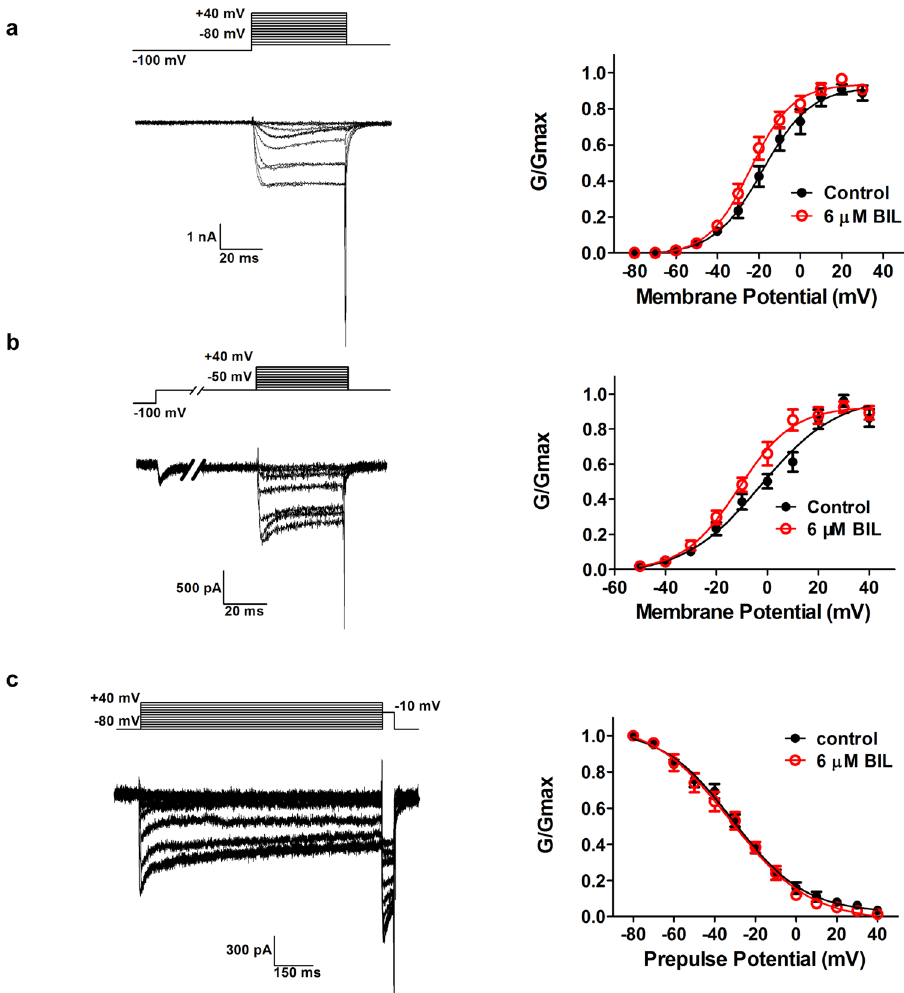
Figure 3. Effects of Bilirubin on activation and steady-state inactivation of VGCCs in bushy neurons. ( a ) Representative traces recorded from a bushy neuron obtained by a 50 ms prepulse at − 100 mV to various potentials followed by a 40 ms test pulse to + 40 mV (10 mV increments) are shown (left). Activation of VGCCs in control (black circles) and bilirubin group (red circles) were then fit by a Boltzmann equation . Exposure of bushy neurons to 6 μ M bilirubin caused a shift in steady-state activation toward more negative potentials (right). ( b ) Activation of the HVA current was measured on stepping to a test voltage from − 50 mV to + 40 mV (10 mV increments) following a prepulse hyperpolarizing at − 100 mV for 50 ms and step to − 50 mV for 100 ms. The left figure shows representative traces. Activation of VGCCs in control (black circles) and bilirubin group (red circles) were fit by a Boltzmann equation. Exposure of bushy neurons to 6 μ M bilirubin caused a left shift on activation curve (right). ( c ) Representative traces recorded from a bushy neuron obtained by a 1 s prepulse to various potentials (10 mV increments) followed by a 50 ms test pulse to − 10 mV are shown (left). Steady- state inactivation of VGCCs in control (black circles) and bilirubin group (red circles) were fit to a Boltzmann relationship. Exposure of bushy neurons to 6 μ M bilirubin caused no significantly effect on the steady-state inactivation curve